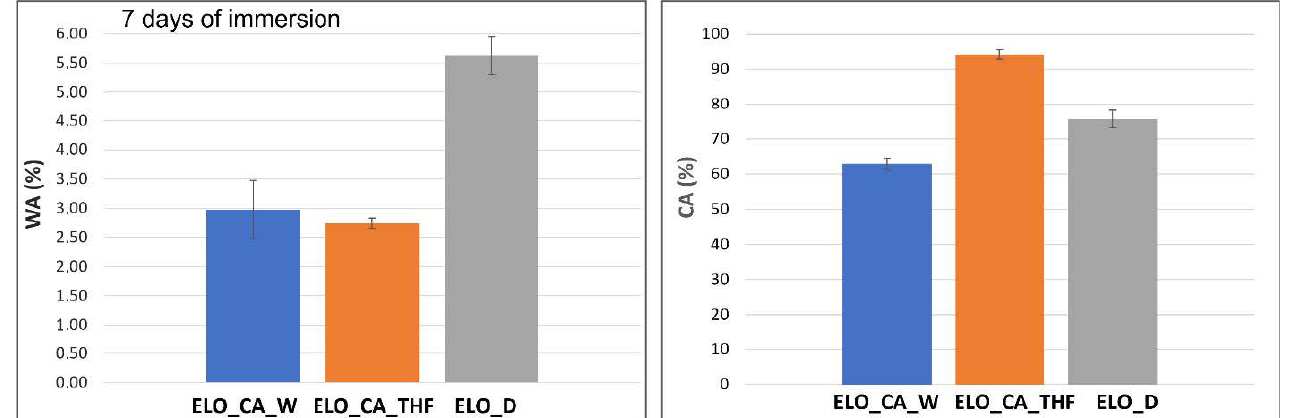
Figure 10. Graphical representation of measured WA (%) and CA ( ◦ ). For the studied ELO-based crosslinked networks.